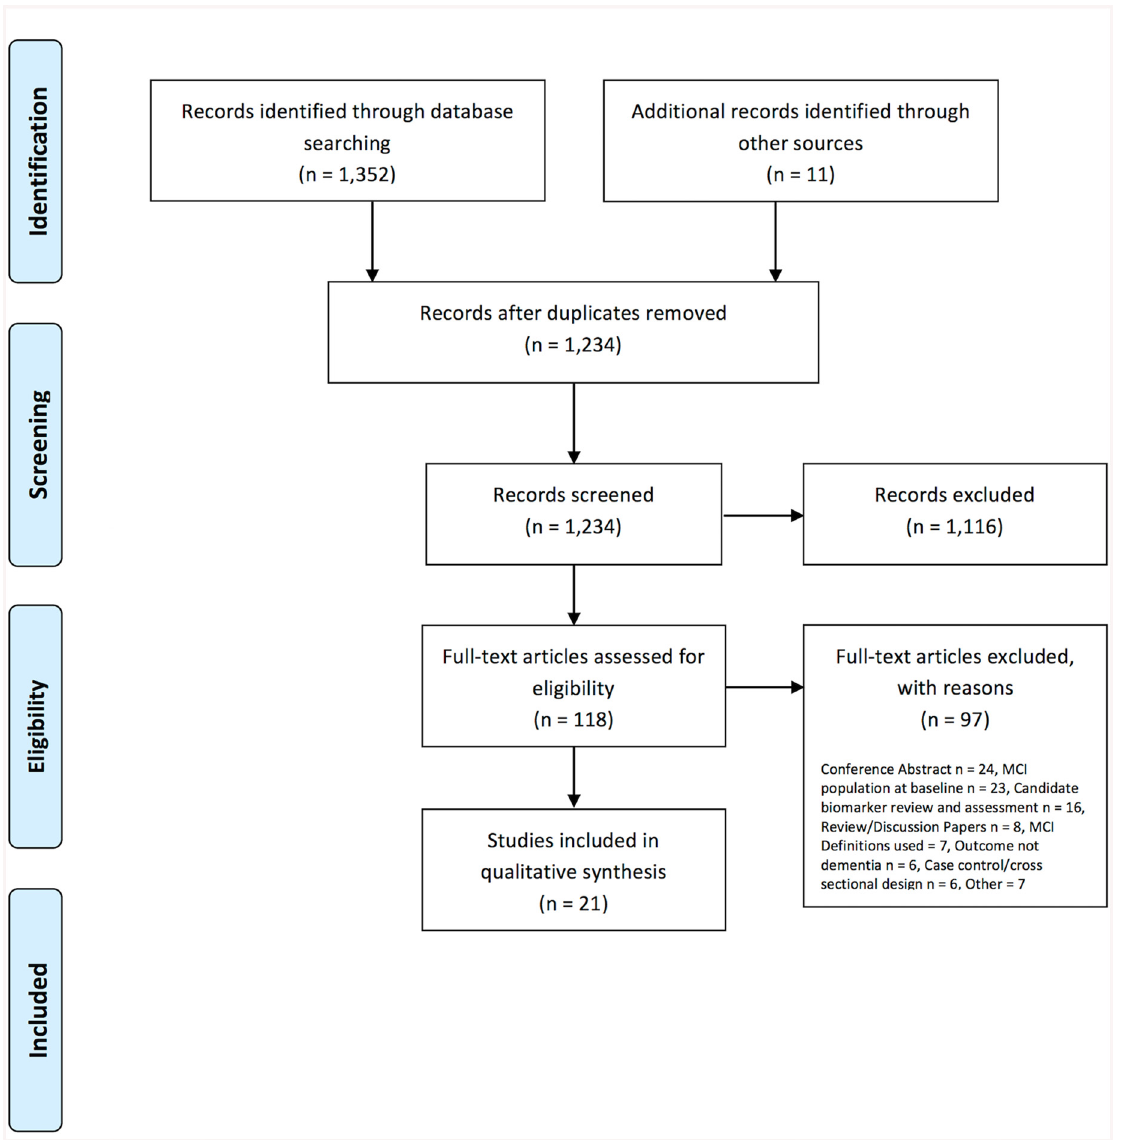
Fig 1. PRISMA (2009) flow diagram of article